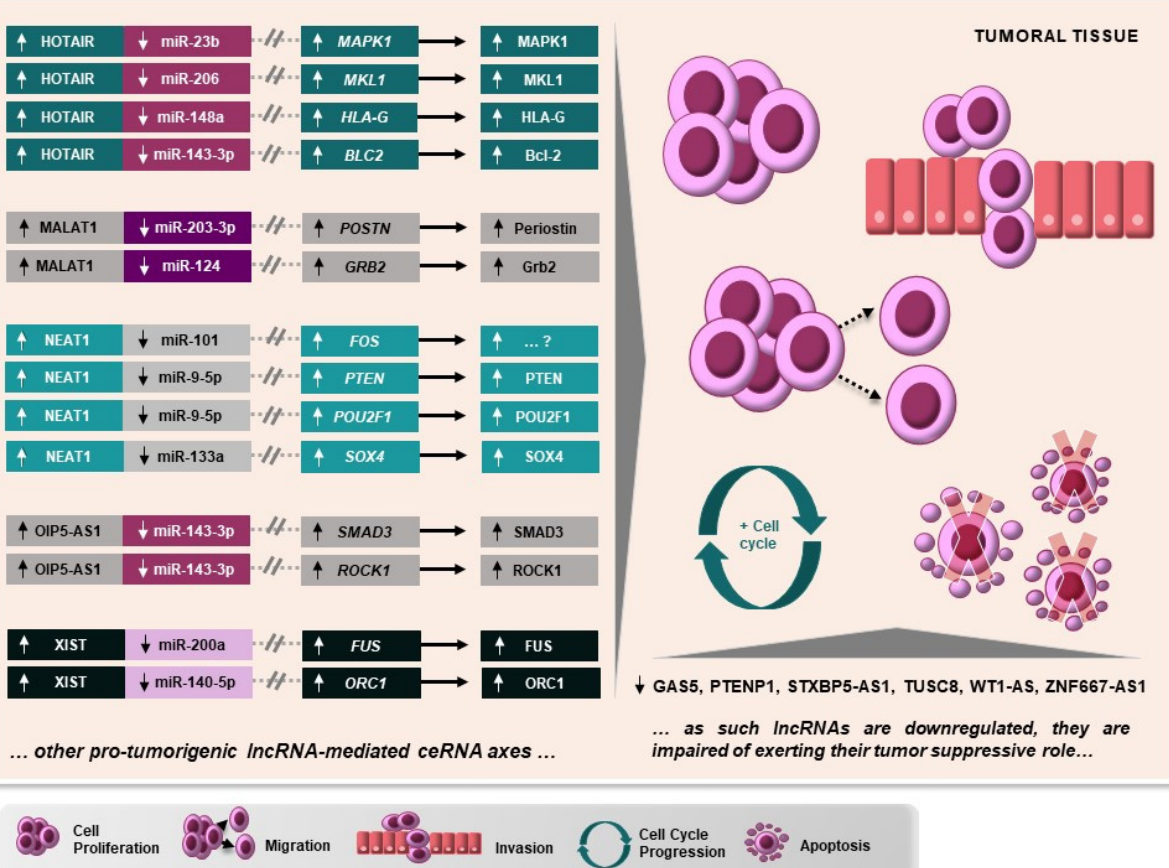
Figure 2. LncRNA-mediated ceRNA crosstalk in tumoral cervical tissue. Some lncRNA-mediated ceRNA axes (led by upregulated lncRNAs, as HOTAIR, MALAT1, NEAT1, OIP5-AS1, and XIST) seem to primarily take place in tumoral tissue, leading to a state of constant cell proliferation and cell cycle progression, inducing migration/invasion, and preventing apoptosis. Note that as tumor-suppressive lncRNAs such as GAS5, PTENP1, STXBP5-AS1, TUSC8, WT1-AS, and ZNF667-AS1 are downregulated in cervical tumoral tissue, they are impaired from exerting a final tumor-suppressive effect through different lncRNA-mediated ceRNA axes. The protein FOS is represented by a question mark (?) in order to emphasize that, although it has not yet been investigated, it probably presents a deregulated pattern of expression, as observed for the respective gene that codes this specific protein.